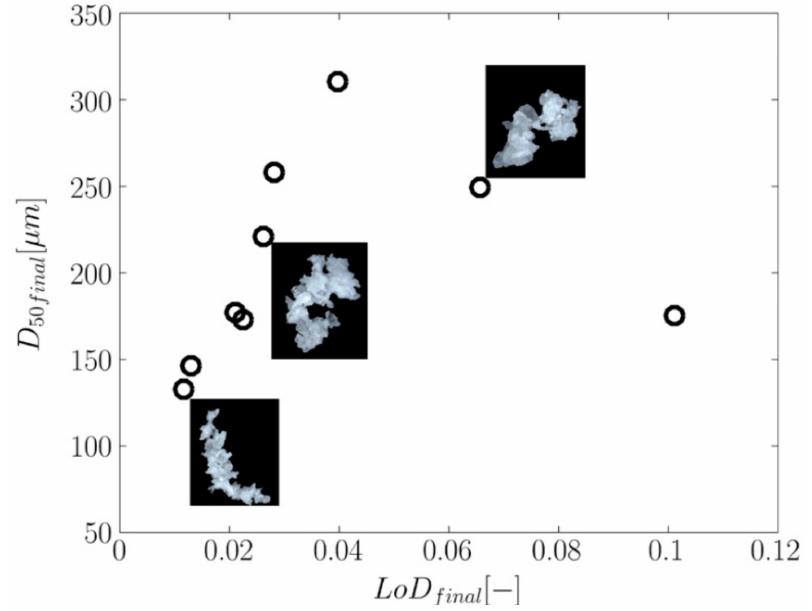
Figure 2. Dependence of final granule size on the final LoD [9,10] (figure has been reused with permission from the